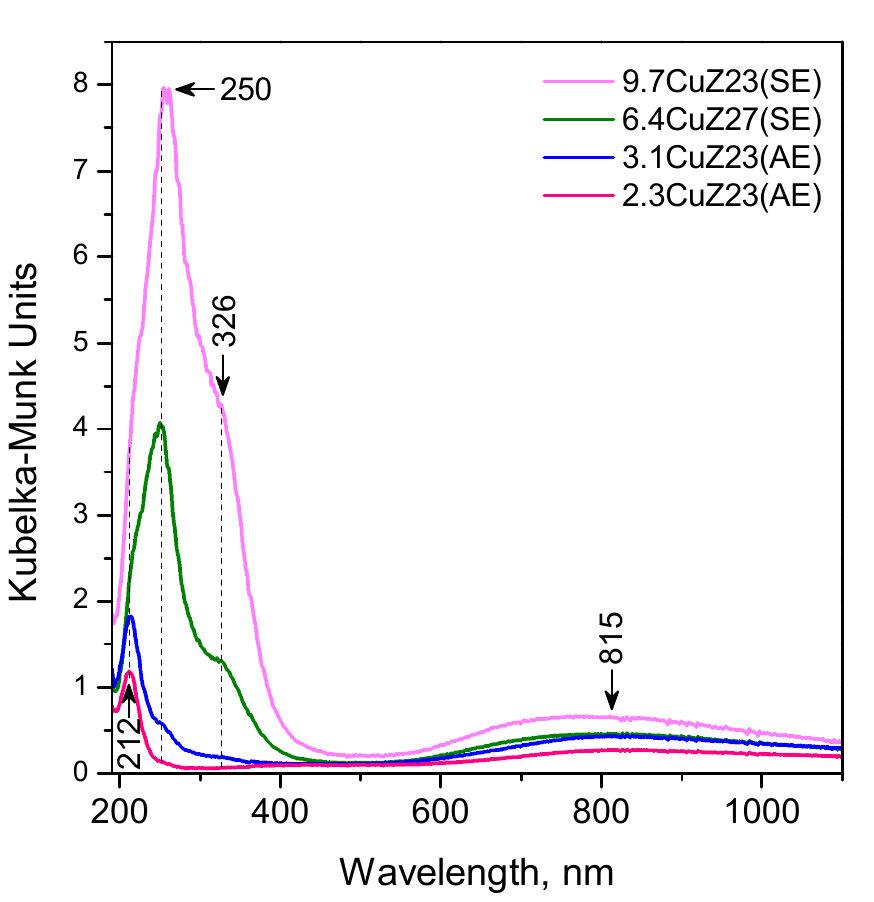
Figure 6. DR UV-Vis spectra of the Cu-exchanged zeolites.